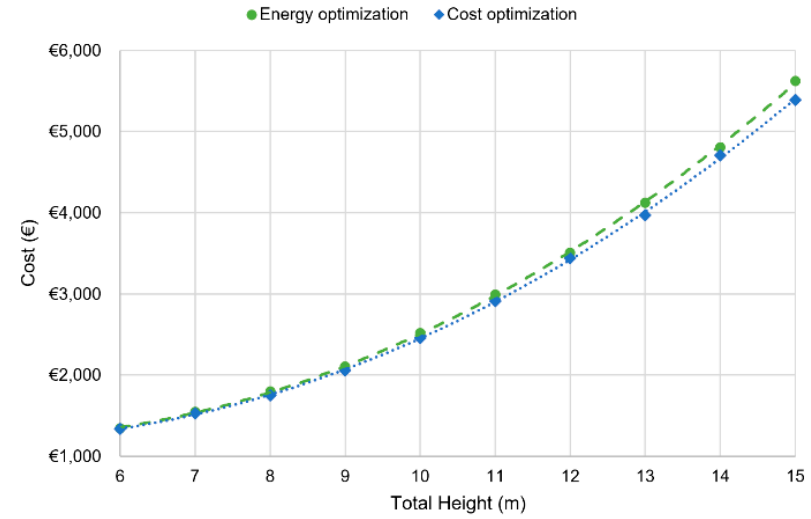
Figure 5. Relation between cost and wall height.